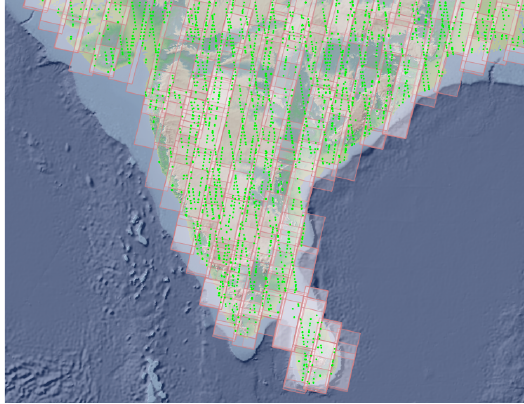
Fig. 8: Active IceSat points (green) on India block